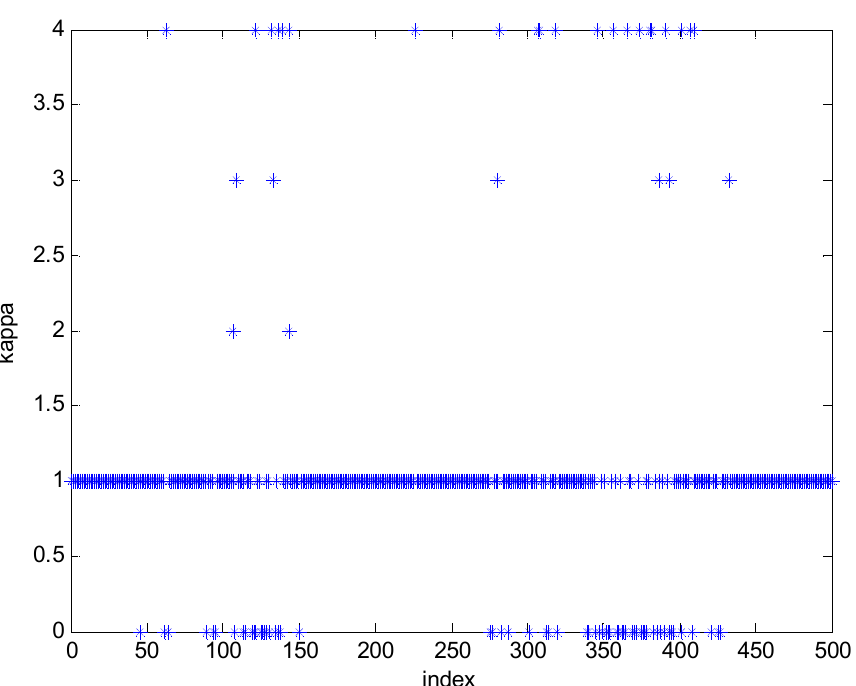
Figure 3. Scaling parameter adjustment results (minimum value of the scaling parameter: 0, maxi- mum value of the scaling parameter: 4).